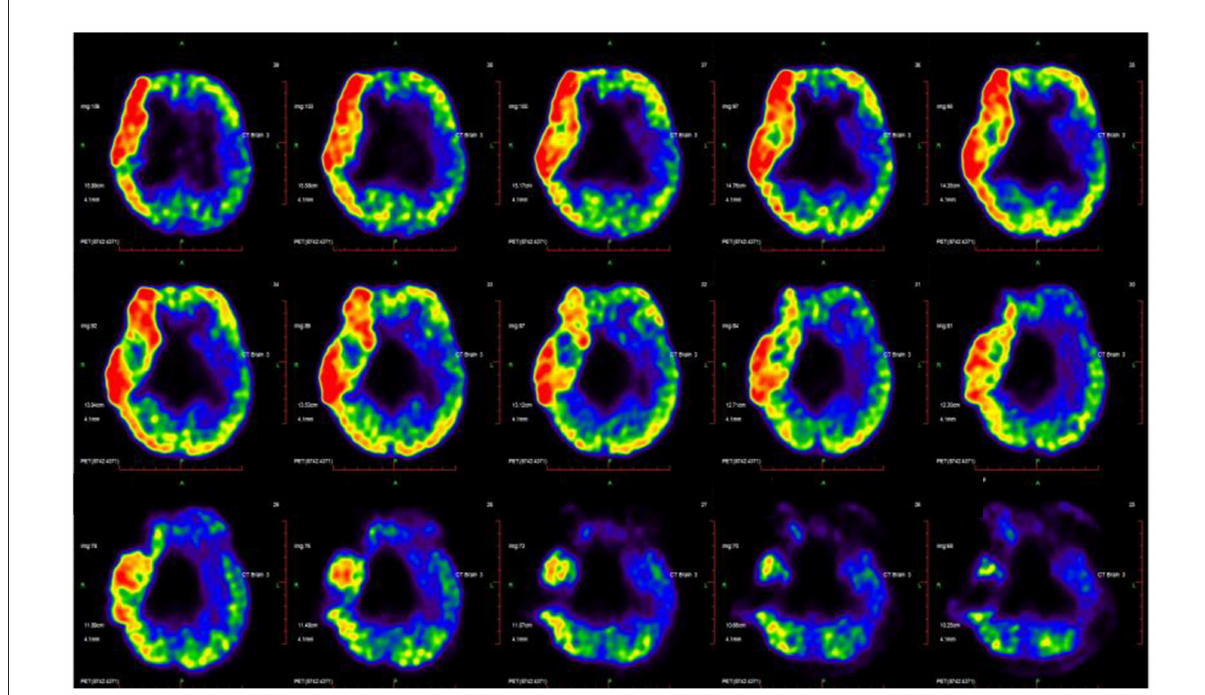
FIGURE4 CP’s disease-related pattern identified by analysis of FDG PET scans from 31 CP patients. The glucose metabolism in the left cerebellum relative higher than the right